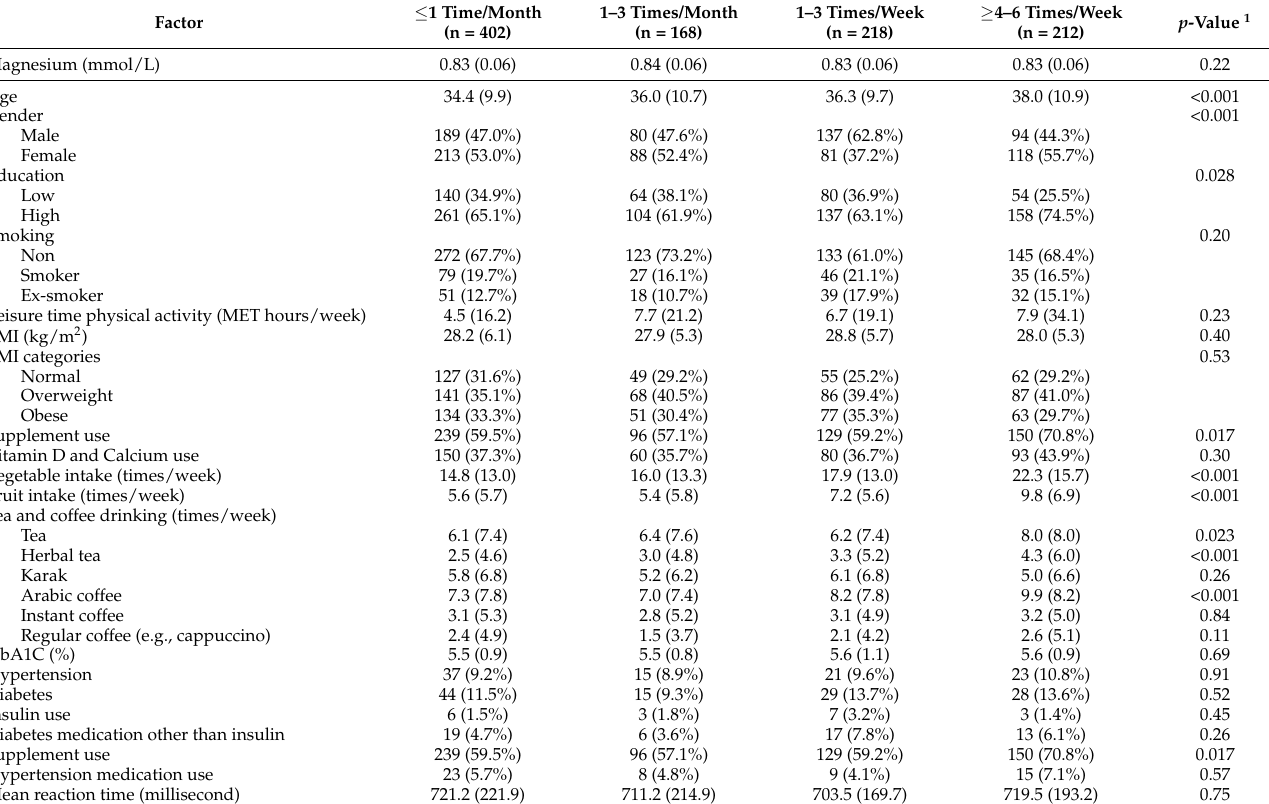
Table 1. Baseline sample characteristics by levels of nuts consumption: Qatar Biobank Study (n = 1000).